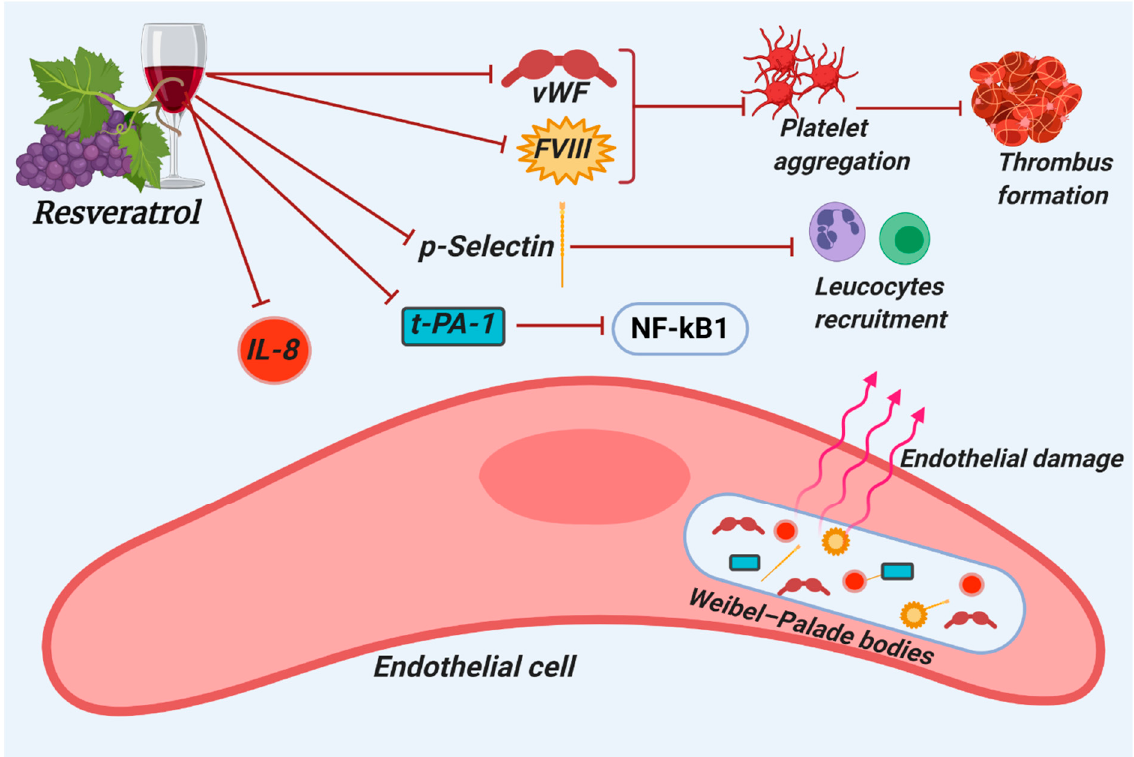
Figure 2. Figure summarizes the antithrombotic properties of resveratrol. Resveratrol counteracts the expression of thrombosis-associated markers such as Von Willebrand factor (vWF), factor VIII (FVIII), plasminogen activator-1 (t-PA-1), and P-selectin, which results in the inhibition of leucocytes recruitment, platelet aggregation and thrombus formation.